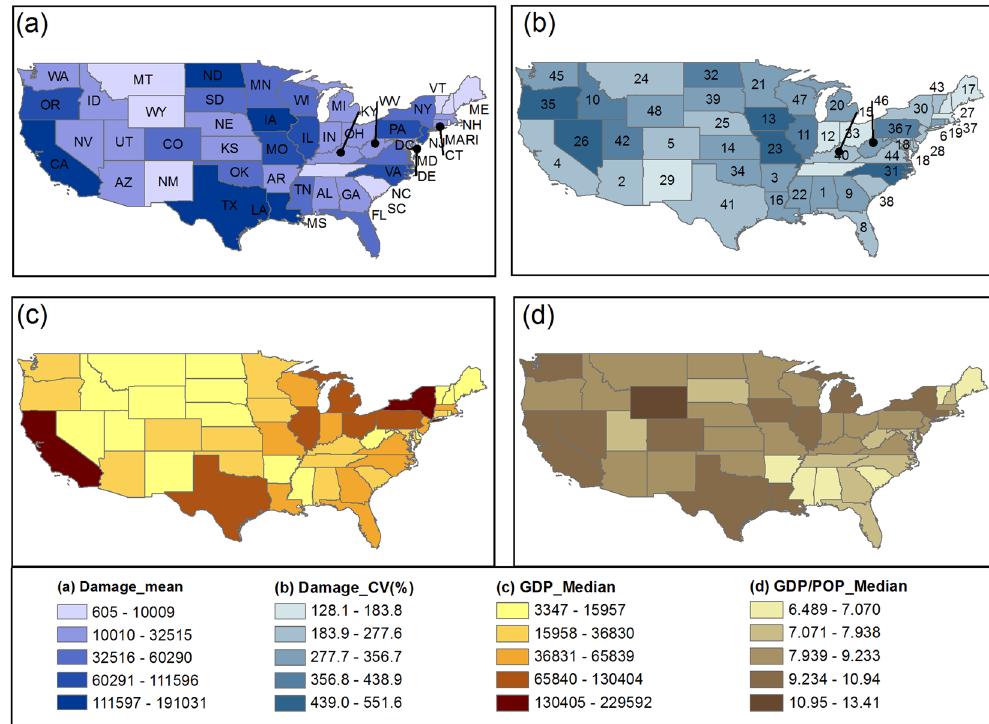
Figure 2. Spatial distribution of state-level ( a ) mean annual flood damage (in thousands of current dollars), ( b ) the standard deviation of flood damage normalized by the mean (i.e., coefficient of variation, CV), ( c ) median GDP (in millions of current dollars) and ( d ) median GDP/median POP (in thousands) for the period of 1955– 99. Figure was created using software ArcGIS 10.1